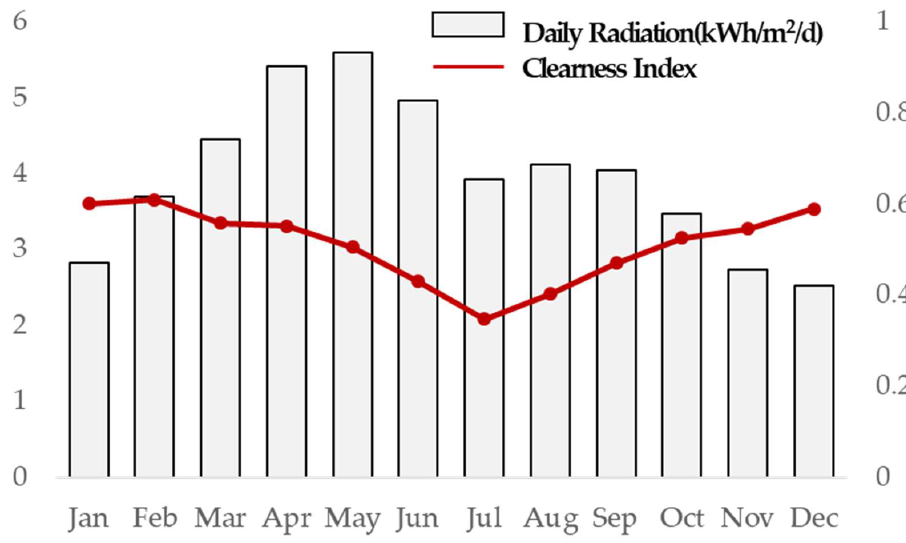
Figure 2. Global Horizontal Radiation (solar radiation and clearness index). Table 1. Solar Resource and Temperature Inputs